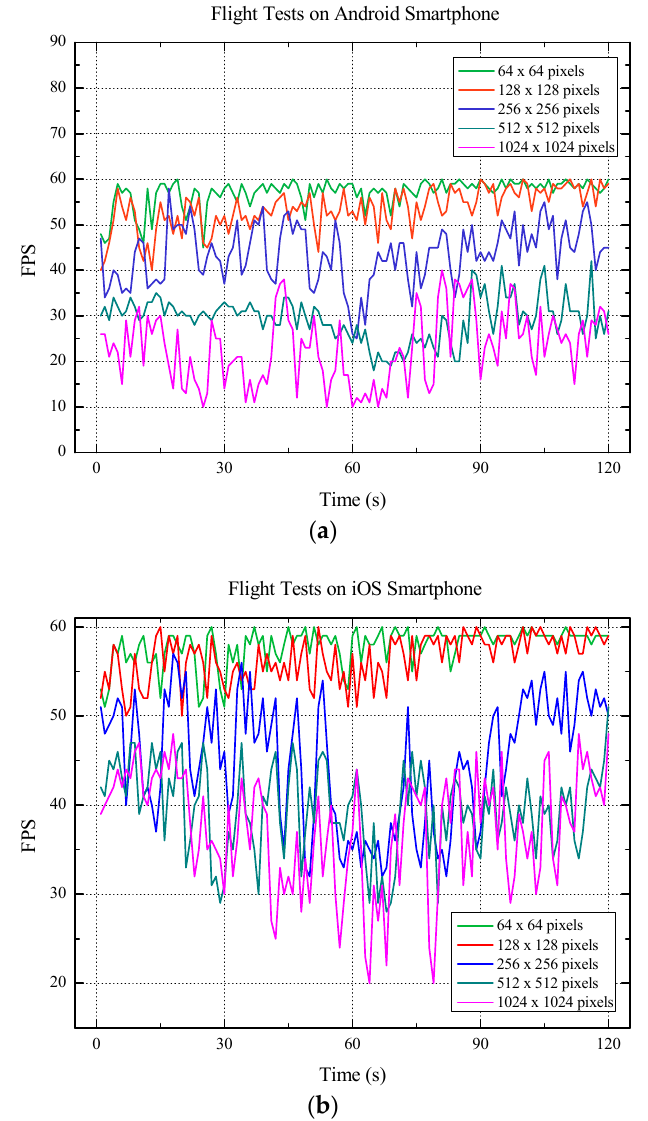
Figure 5. Tests of the influence of the loading image tiles of various tile sizes on the rendering frame rate: ( a ) flight tests on the Android smartphone; ( b ) flight tests on the iOS smartphone.